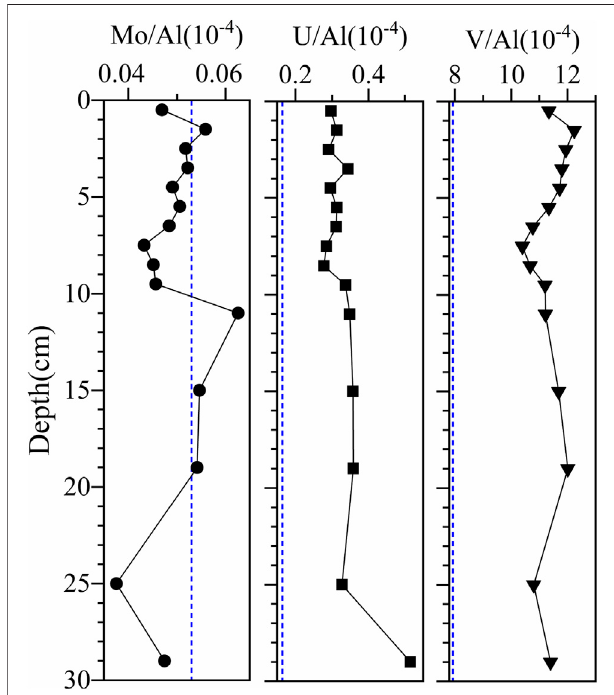
FIGURE3| Down-core variations ofRSE/Alvaluesincore 3,050 – 2,and the blue dotted line represents average values of RSE/Al in post Archean Australian shale